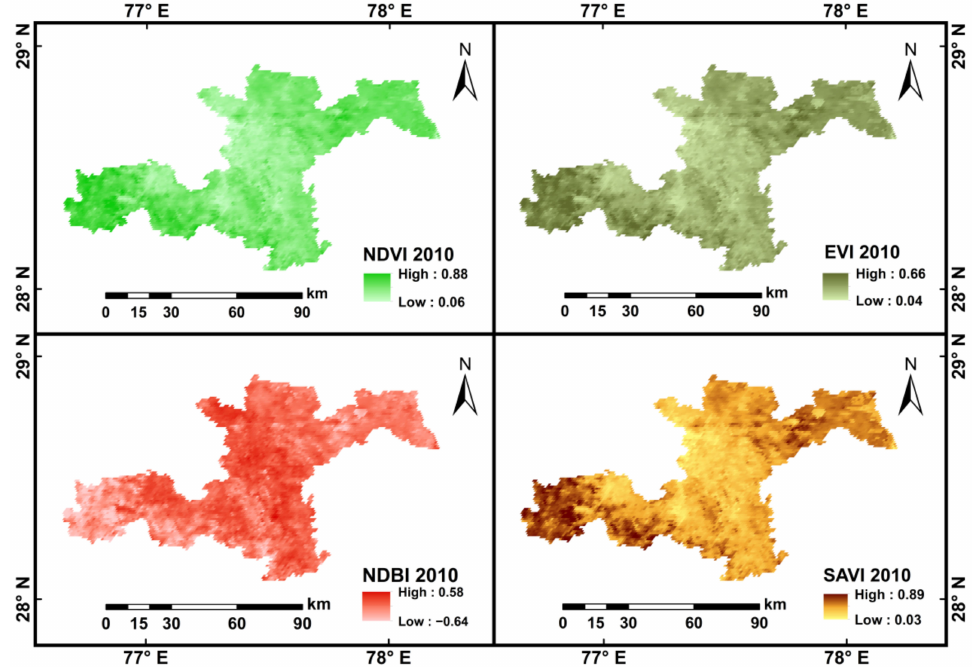
Figure 6. Maps of NDVI, NDBI, EVI and SAVI of Terra MODIS